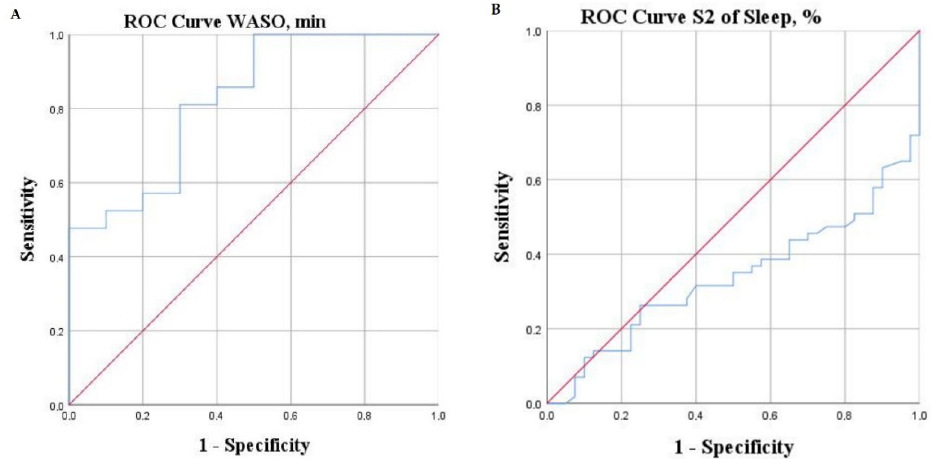
Figure 3. ROC curves of PSG parameters: WASO ( A ), S 2 ( B ).